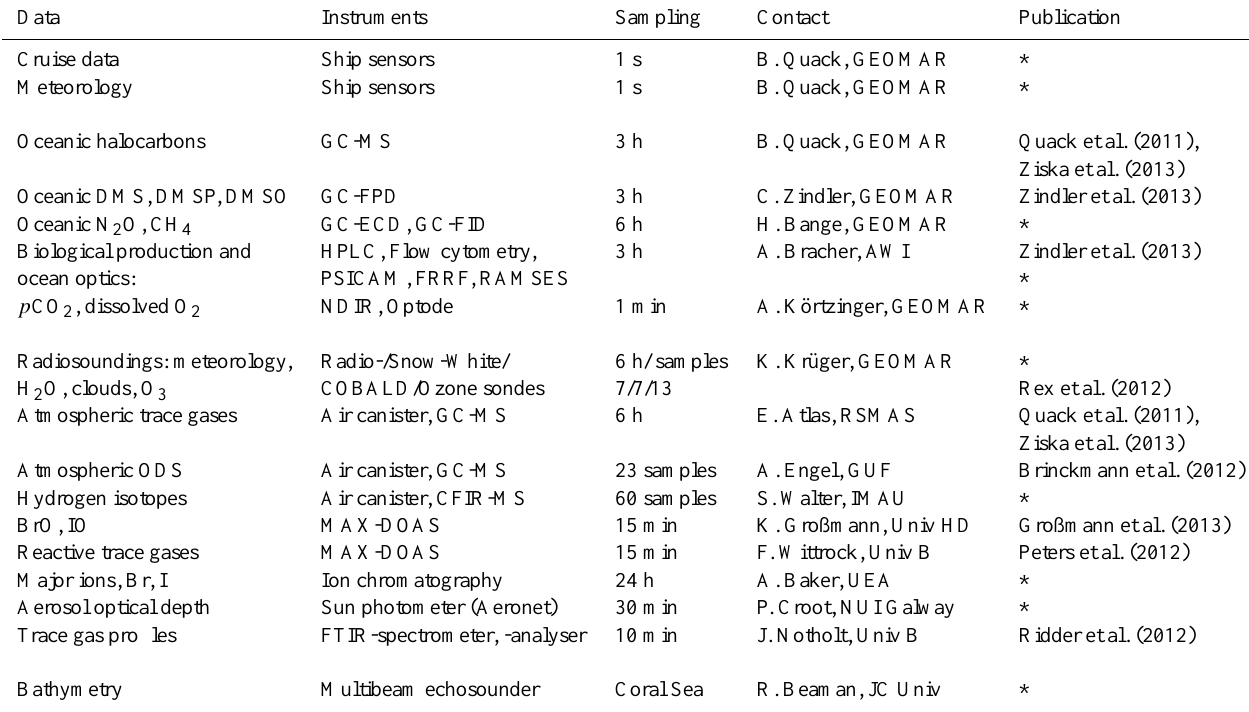
Table 1. Measurement table from the TransBrom Sonne cruise during October 2009. Data are stored at and can be requested from https: //portal.geomar.de/ ( ∗ Quack and Krüger, IFM-GEOMAR Cruise Report No. 37,